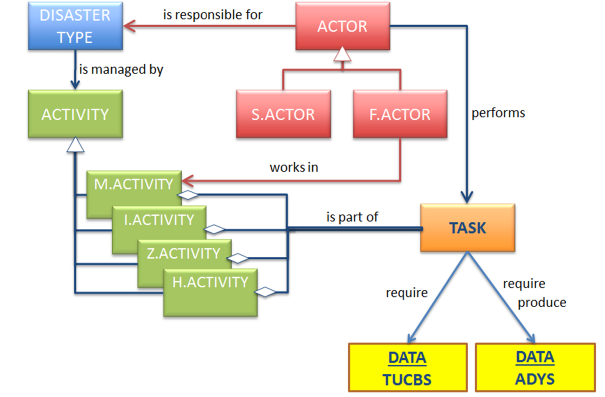
Table 1. Landslide activities for the mitigation phase.